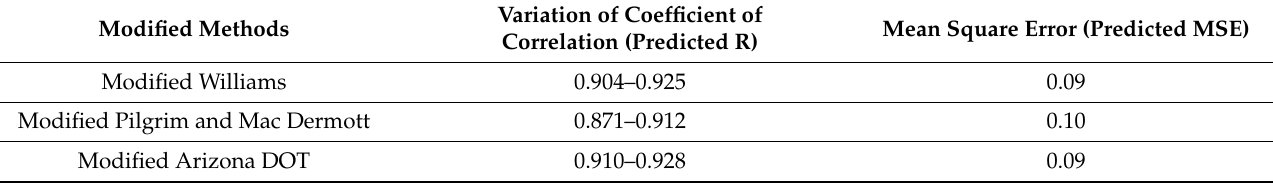
Table 10. The results of cross